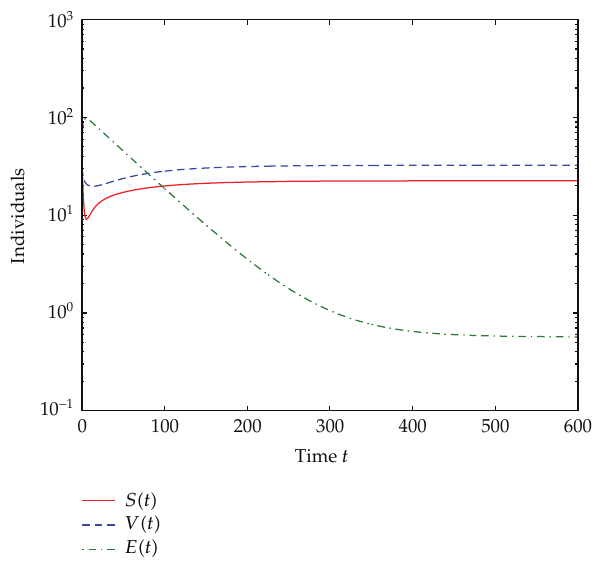
Figure 4: When R 0 > 1, the endemic equilibrium P ∗ is globally asymptotically stable.